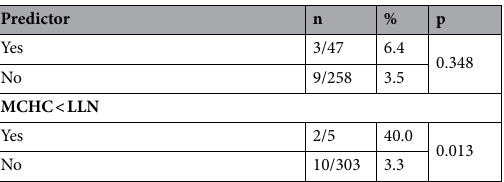
Table 4. Transfusion frequency in different patient cohorts. LLN lower limit of normal.